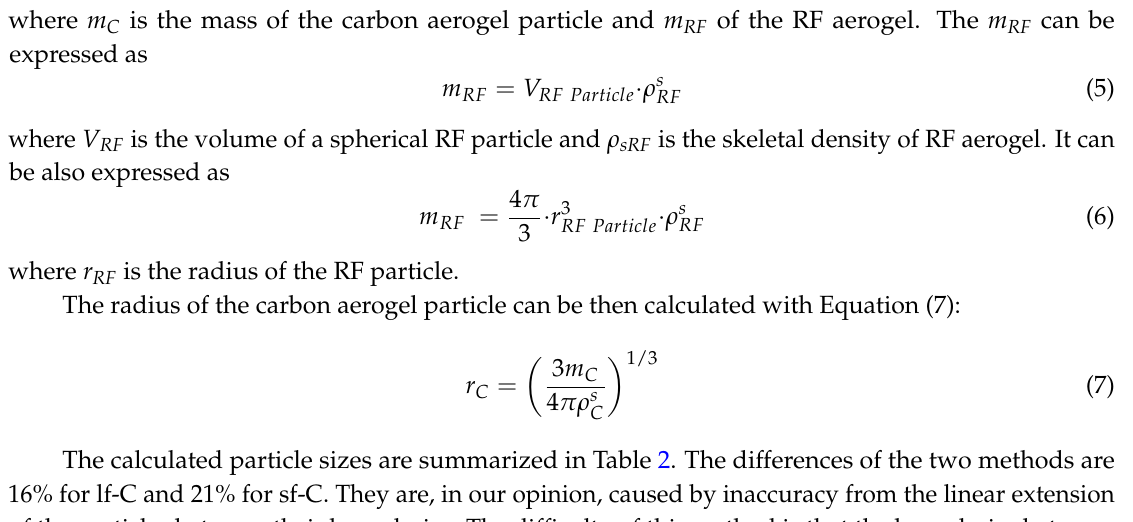
Figure 4. Microstructure of sf-C aerogel with an average particle size of 0.09 µm and an average pore size of about 104 nm.